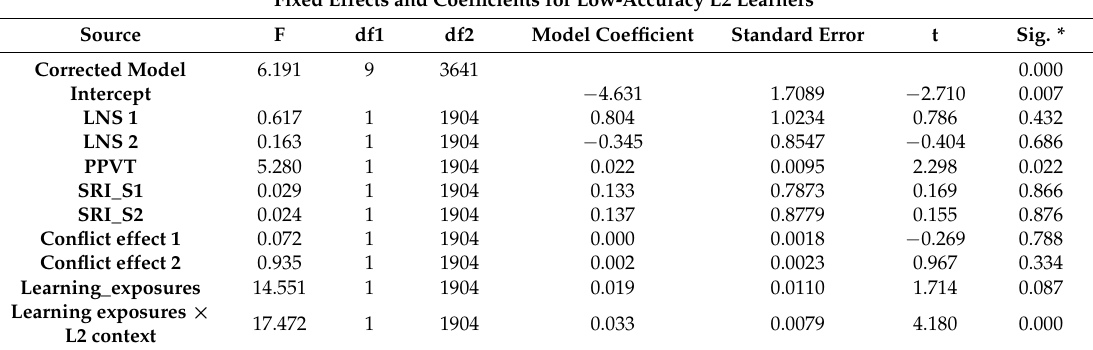
Table 8. Overview of individual difference results from binomial logistic regression in low-accuracy L2 learners.